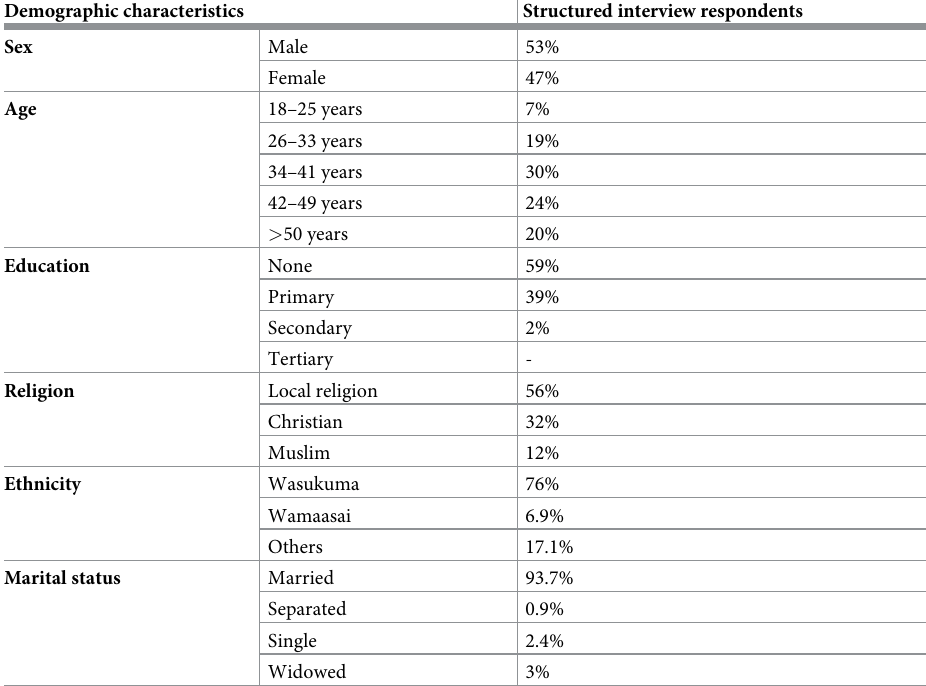
Table 1. Summary of the socio demographic characteristics of the